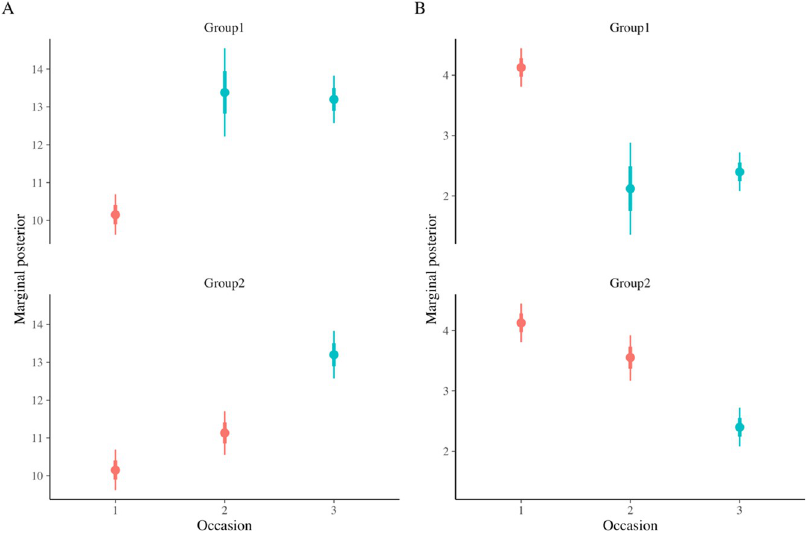
Fig 2. Median, 66% and 95% CI for the posterior distribution of means for both groups (Group 1 = intervention between Occ1 & Occ2; Group 2 = intervention between Occ2 & Occ3) on Understanding score (A) and No Concept score (B). Blue intervals indicate means after implementation of the intervention; red intervals indicate means before the implementation of the